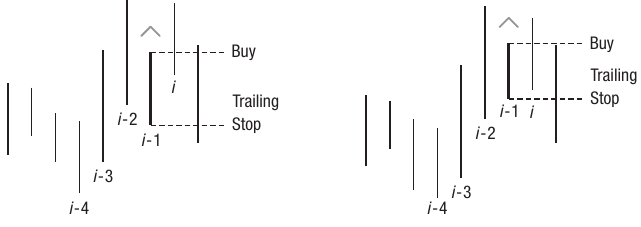
Fig. 2. Examples of proposed chart